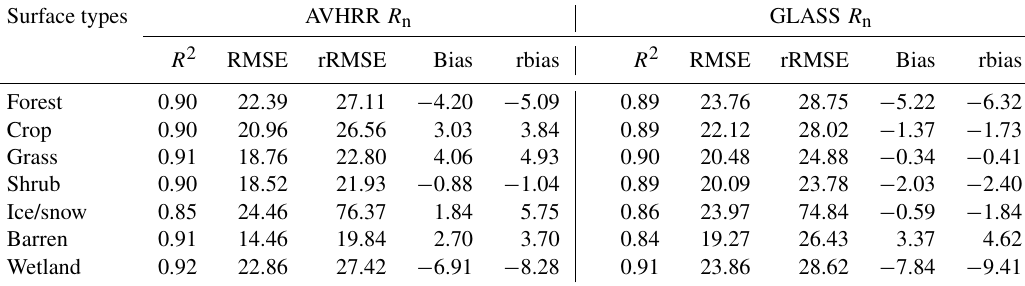
Figure 8. Coincident time series of the AVHRR, GLASS, MERRA-2, and CERES-SYN R n retrievals and ground-based measurements over seven sites representing different surface cover types for (a) ARM_E06 (38.061 ◦ , − 99.134 ◦ ), (b) BSRN_DRA (36.626 ◦ , − 116.018 ◦ ), (c) Lath_CA-NS7 (56.635 ◦ , − 99.948 ◦ ), (d) Lath_DE-Har (47.934 ◦ , 7.601 ◦ ), (e) Lath_UK-AMo (55.791 ◦ , − 3.238 ◦ ), (f) PM-SCO_U (72.393 ◦ , − 27.233 ◦ ), and (g) SF_BND (40.050 ◦ , − 88.37 ◦ ). Table 7. Evaluation of the AVHRR and GLASS R n retrievals for different surface cover